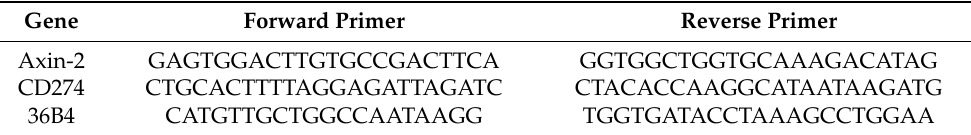
Table 1. Primer sequences for quantitative real